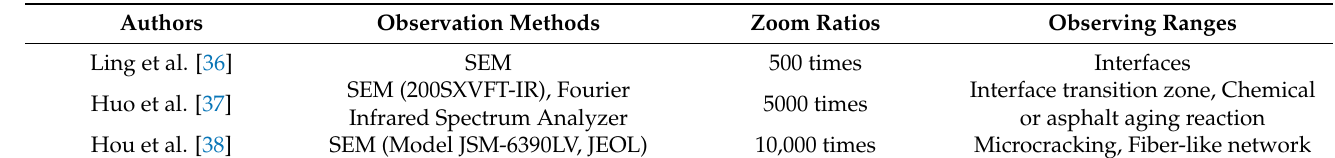
Table 1. Methods of microscopic observation for GSP.